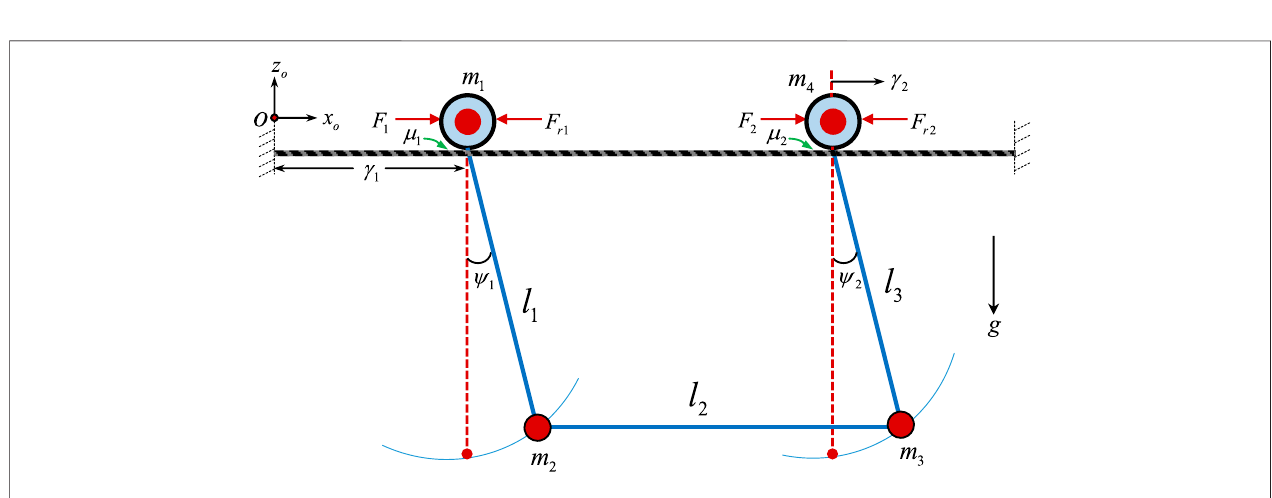
FIGURE 2 | The schematics of the dual-arm PTLI robot represented as two rollers attached to two coupled cylindrical arms.